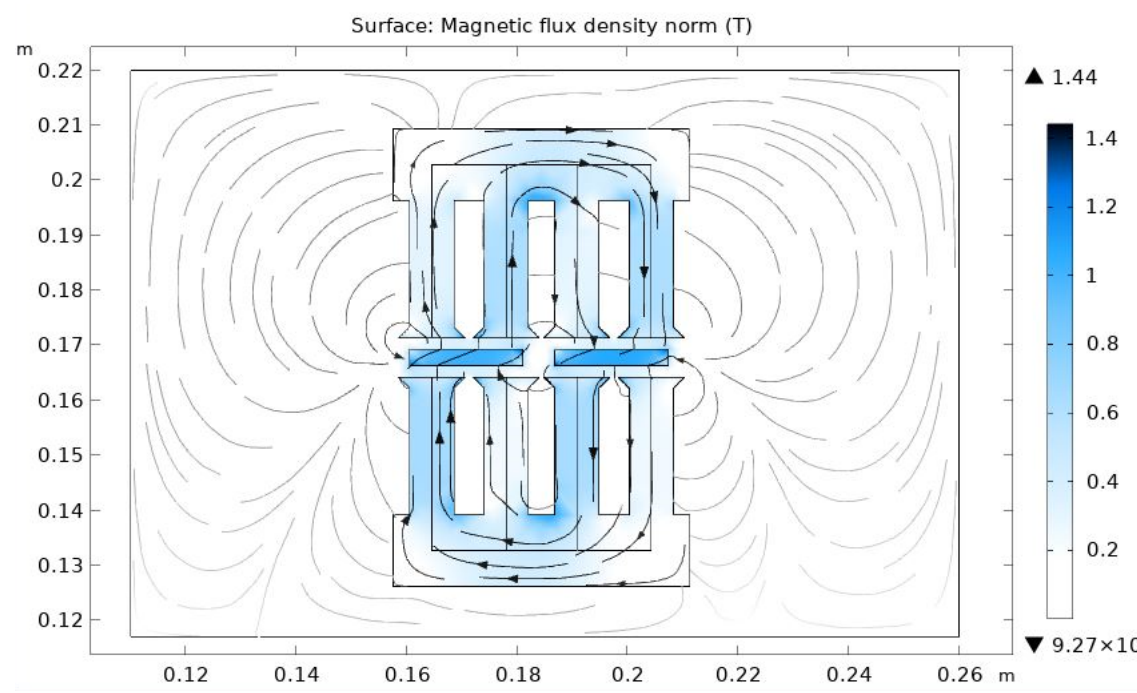
Figure 4. The workspace window for the calculation of a magnetic field.